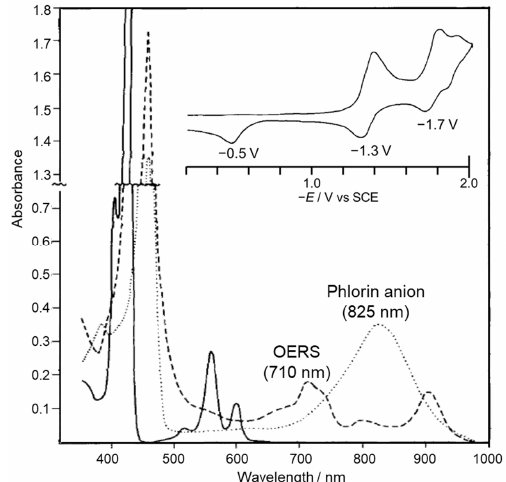
Figure 4. UV–vis absorption spectra of ZnTPP (solid line) and the reduction products (OERS: broken line, and phlorin anion: dotted line) in DMF-containing electrolytes in thin layer cell. Inset shows CV of ZnTPP (Scan rate: 0.033 V s − 1 ). Concentration: 1.5 × 10 − 3 M ZnTPP. Adapted with permission from [39] (partially modified). © The Electrochemical Society. Reproduced by permission of IOP Publishing. All rights reserved.